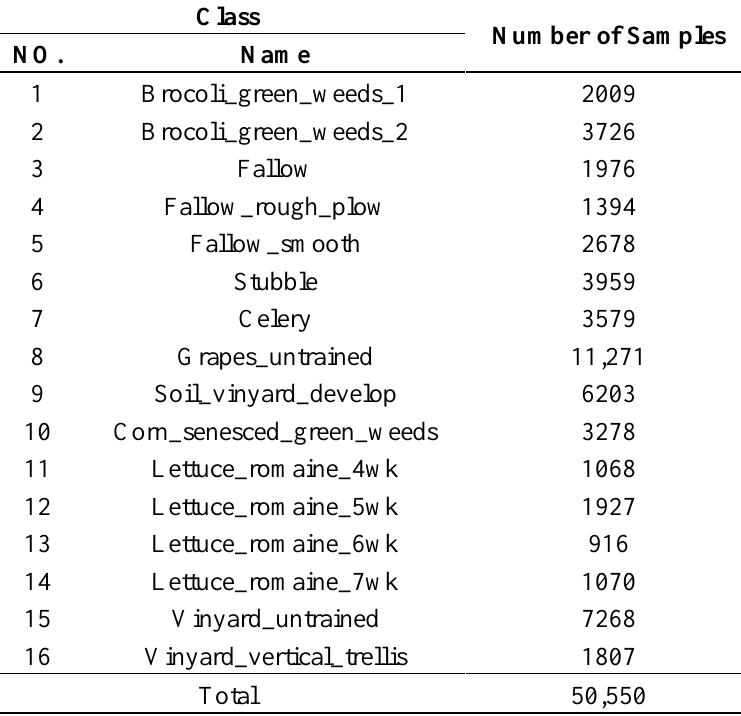
Table 2. Labeled samples for the Salinas dataset.